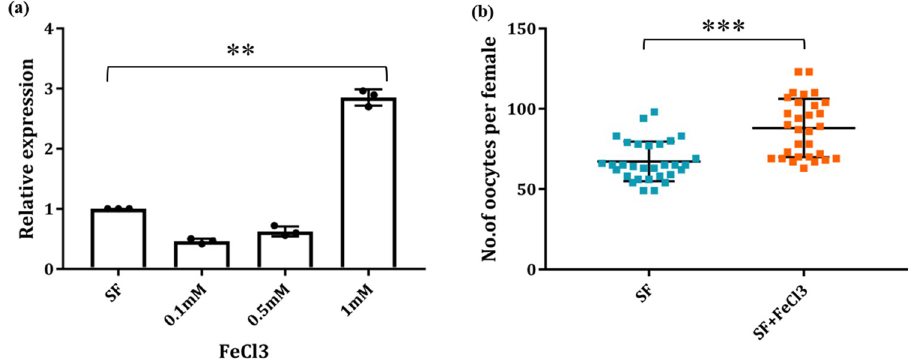
Fig 5. mRNA level augmentation of AcTrf1a transcripts on iron supplemented diet and effect on the mosquito fecundity. Female mosquitoes were allowed to feed on different iron concentrations prepared in sugar solution and the mRNA level of target transcripts was measured in the fat-body. (a) Comparative transcriptional profiling of AcTrf1a in fat-body tissue collected from control and treatment groups. An enriched expression ( p < 0 . 0018 )was observed at 1 mM conc. of iron supplemented diet (n = 20–25, N = 3); Data represented in the figure were from three independent biological replicates, where each dot is equivalent to replicate. Statistical analysis was done using one-way ANOVA viz � p < 0.05; �� p < 0.005; and ��� p < 0.0005, ( n = represents the number of mosquitoes pooled for sample collection; N = number of replicates); (b) Dot plot showing that iron supplemented diet during the early stage of development just after eclosion leads to enrichment of oocytes ( p < 0 . 00001 ) maturing inside the female ovary. Both the control (SF) and test group (SF+ FeCl 3 ) were allowed to feed on rabbit blood and subsequently kept for ovary assessment for oocyte count (n = 10, N = 3). Data represented in the figure were from three independent biological replicates, where each dot represents number of oocytes present in mature ovary of female mosquito. Statistical analysis was done using Mann–Whitney U test ( n = represents the number of mosquitoes pooled for sample collection; N = number of replicates).